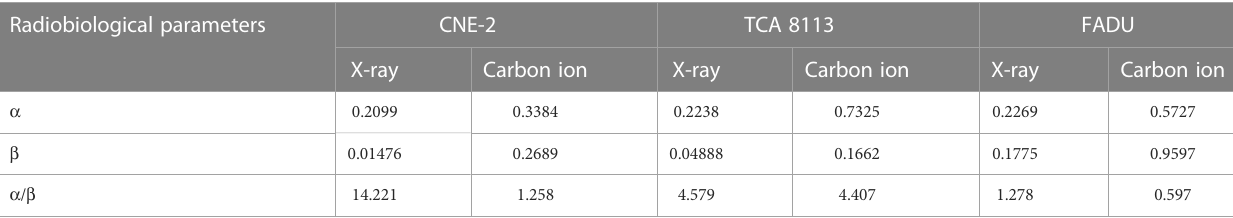
TABLE 1 Data were fi tted to the linear quadratic model for X-ray and carbon ion irradiation in CNE-2, TCA 8113, and FADU cell lines, and the indicated radiobiological parameters were determined from the fi tted curve. Radiobiological